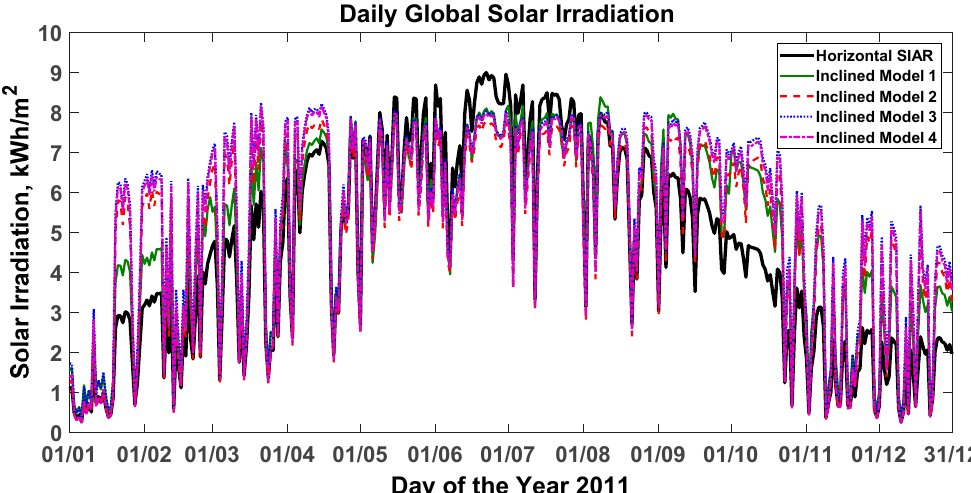
Figure 9. Global solar irradiation measured on the horizontal surface during the year 2011 and estimated for a the solar panel inclined at 45° and oriented to the equator with Inclined Models 1, 2, 3, and 4.